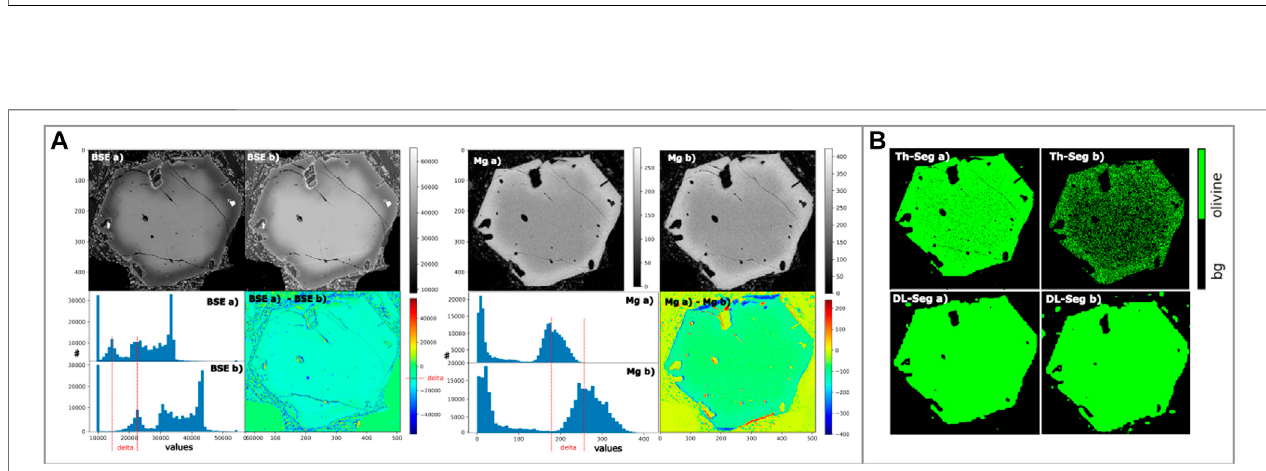
FIGURE5| Panel (A) Samples I) and II) (cf. Figure1 )depict thesame crystalobtainedwitha~ 20daystimegap. BSE (leftA) andEDSX-Ray Mgintensity (rightA) signal drift in sessions acquired with 20 days interval (clearly visible in histograms). False-color image show difference between analytical sessions. Panel (B) Threshold